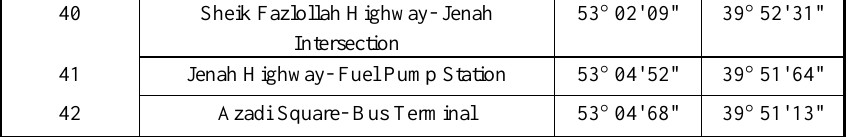
Table 1. The names of the sampling sites and their related geographical coordinates in Tehran